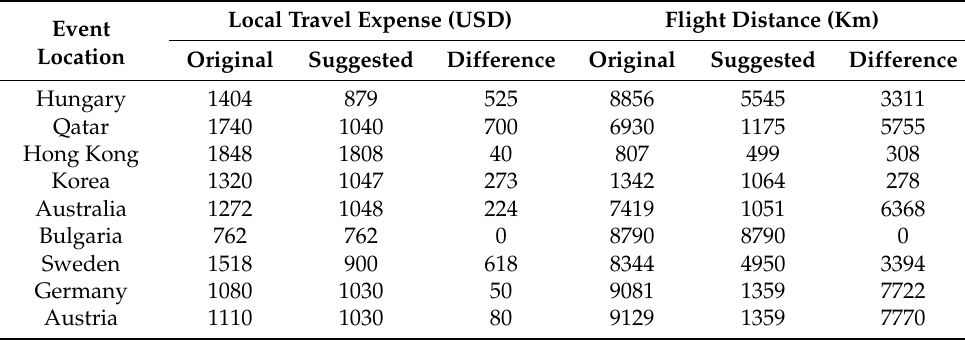
Table 5. Suggested input efficiency targets for the 2019 ITTF World